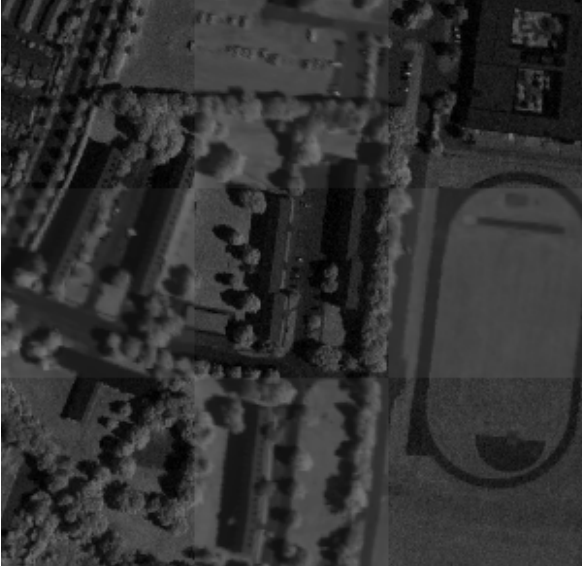
Figure 8: Subsection of co-registered SWIR and VNIR